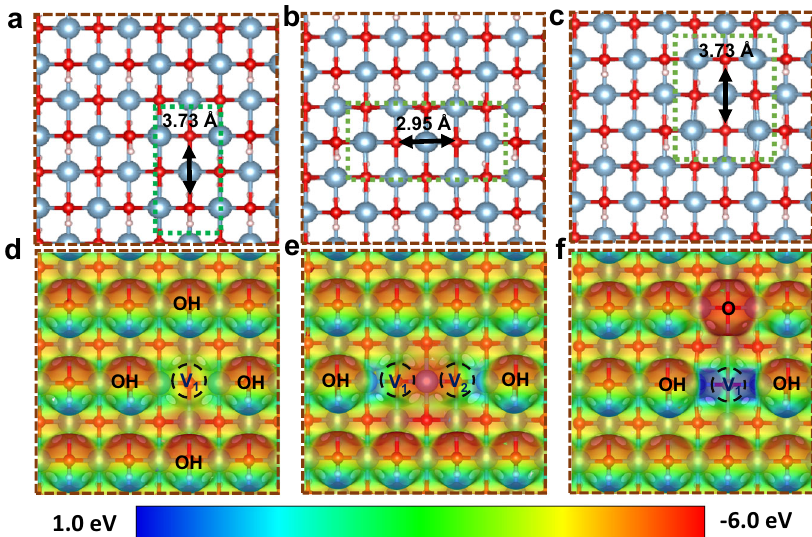
Fig. 6 Images of possible constructed solid surface frustrated Lewis pairs on AlOOH (010). Optimized structure of AlOOH surface with one OH defect a , two OH defects b and one OH v and O Hv c . Electrondensity isosurface of AlOOH surface with one OH defect d , two OH defects e and one OH v and O Hv f . The color bar represents the electrostatic potential scale.